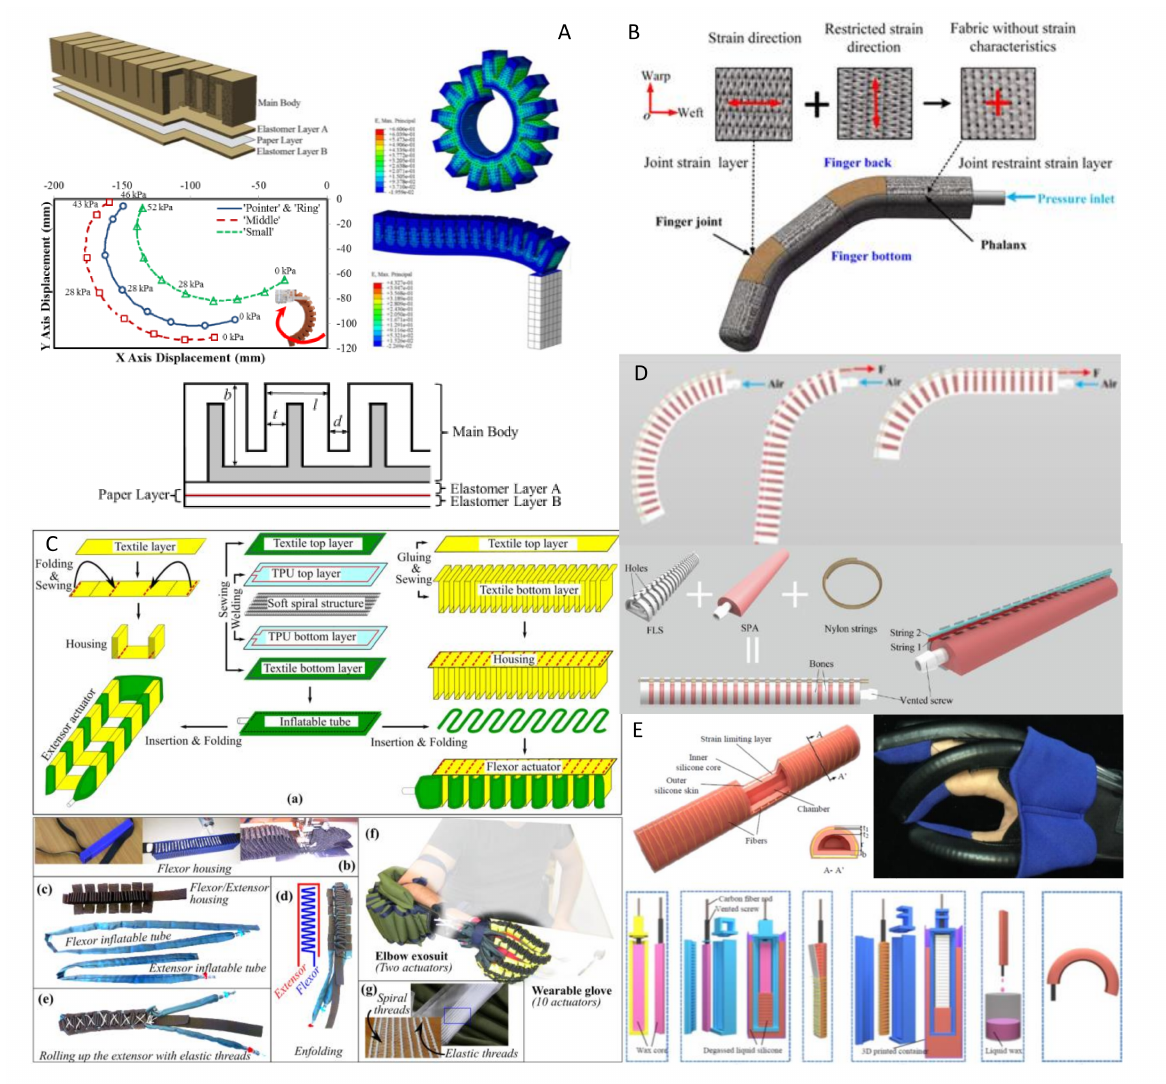
Figure 32. Soft glove actuation solutions. ( A ) Whitesides group design based PneuNets soft actuators, simulated with FEM analysis and experimentally studied. Reprinted/adapted with permission from Ref. [58]. 2013, IEEE. ( B ) FPAs based glove which assists the thumb abduction and fingers flexion and extension [31]. ( C ) FPAs actuators which actively assists fingers flexion and exten- sion [90]. Reprinted/adapted with permission from Ref. [90]. 2019, IEEE. Letters (a–g) refer to the original source. ( D ) Fishbone-inspired soft actuator for soft-gloves presented by Jiang et al. in [84]. Reprinted/adapted with permission from Ref. [84]. 2018, IEEE. ( E ) Soft actuators monolithic fabrica- tion method which combines lost-wax and inverse-flow-injection (IFI) [87]. Reprinted/adapted with permission from Ref. [87]. 2017,